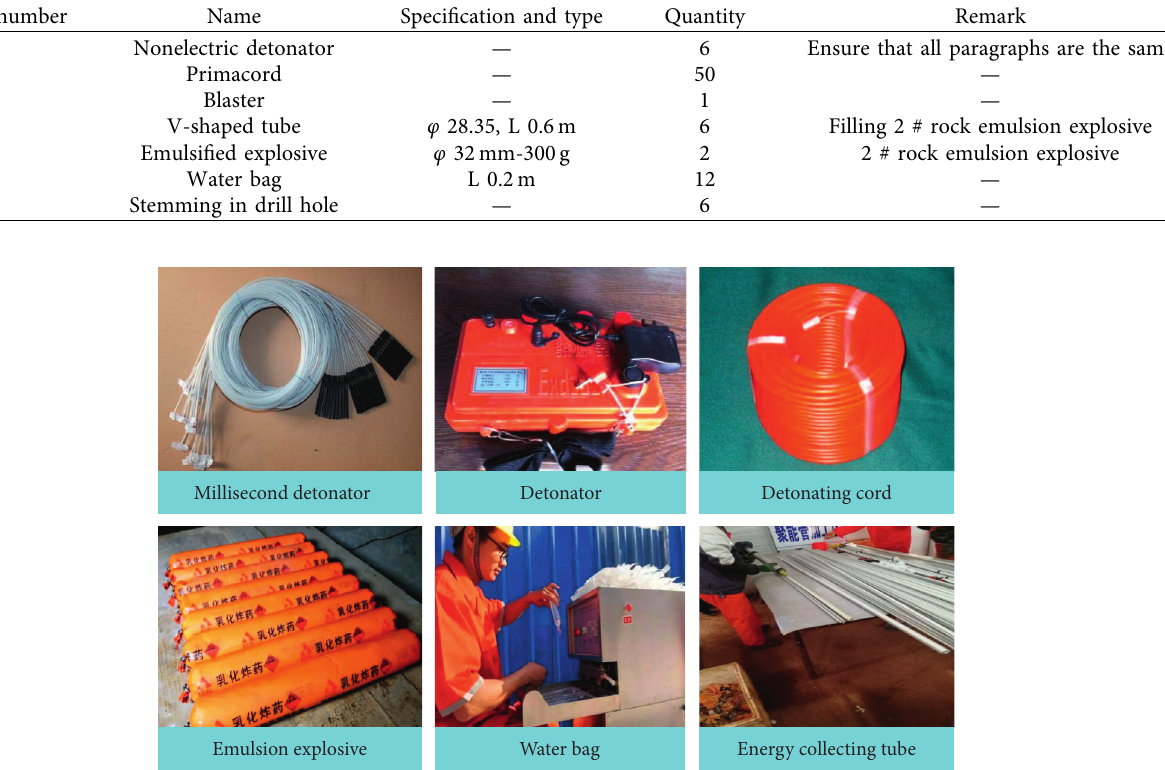
Figure 3: Instruments and materials for the experiment.